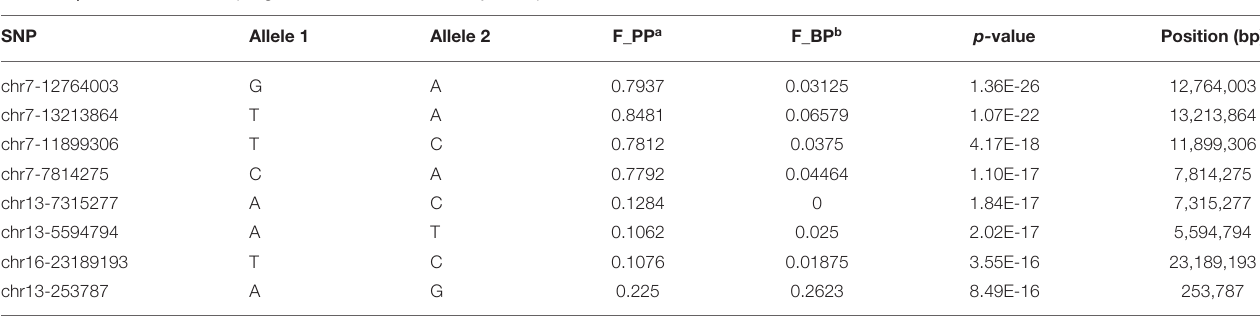
TABLE 2 | Information of the top eight SNPs associated with bay scallop shell color. SNP Allele 1 Allele 2 F_PP a F_BP b p- value Position